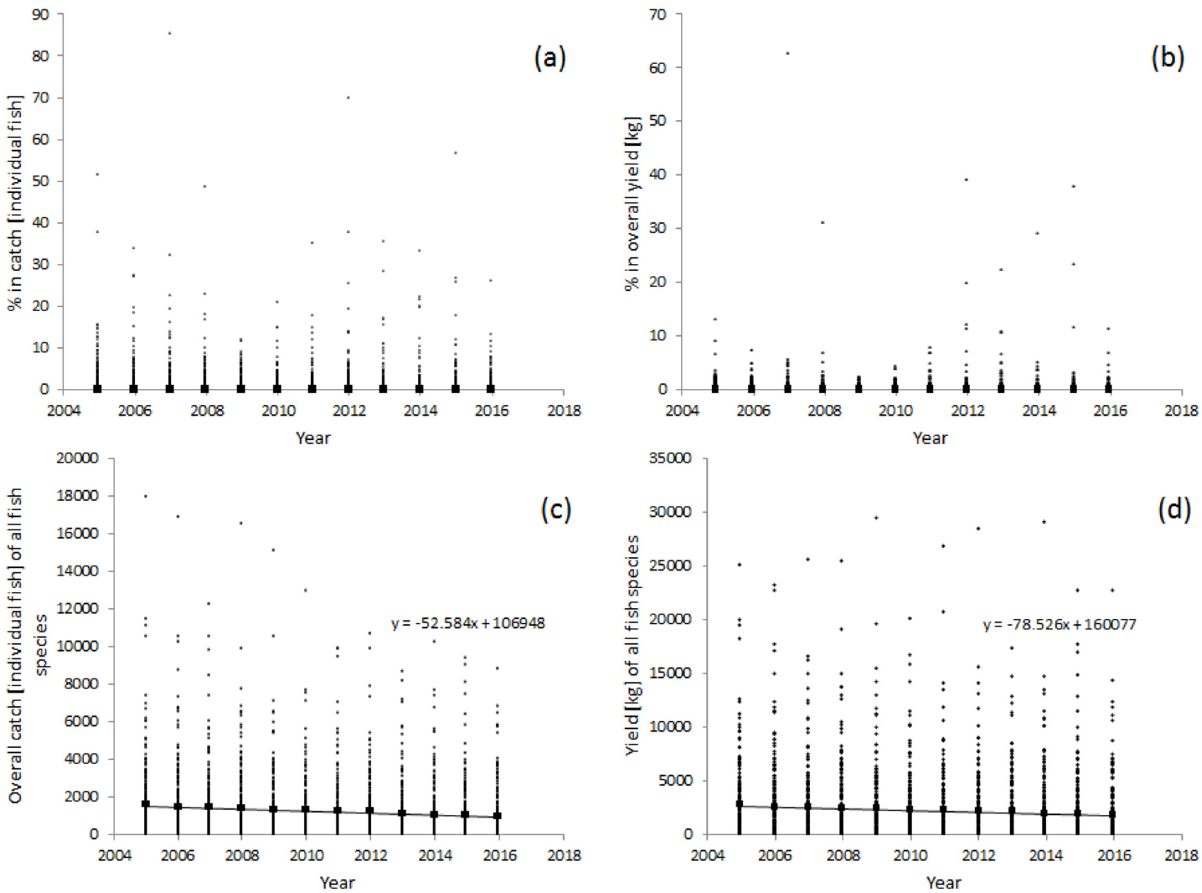
Fig. 3. Proportion of perch in total (all species) recreational catches (a) and yield (b) by fi shing ground. Total catch (c) and yield (d) of all fi sh species.